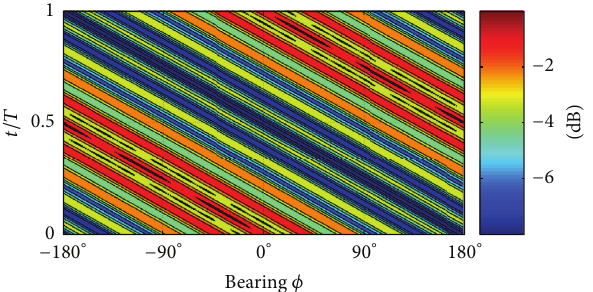
Figure 2: Real (solid) and imaginary (knobby) parts and magnitude (dashed) of embedded co-pol pattern ⟨ a linear scale, with k at bearing 𝜙 and the elevation of k elements are identical, so the knobs every 8 ∘ mark those 𝜙 where the curves also yield the ⟨ DFT (14).